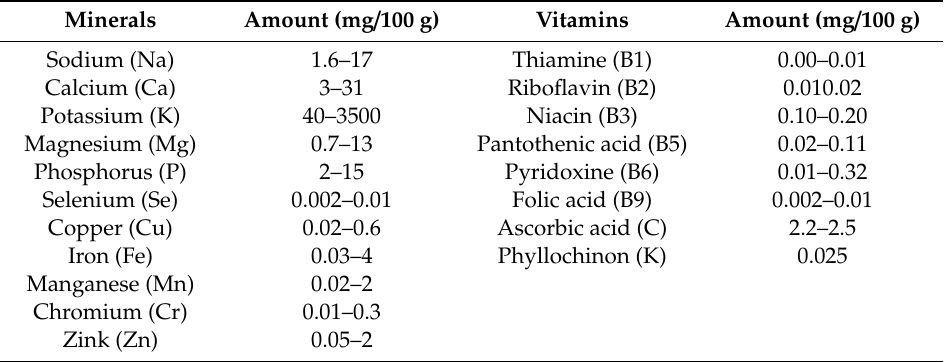
Table 2. Chemical elements found in pure